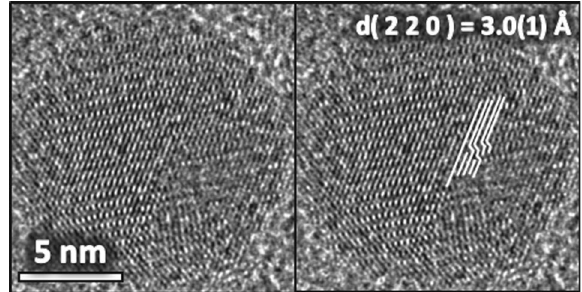
FIG. 6. HRTEM micrographs of one representative NP with visible